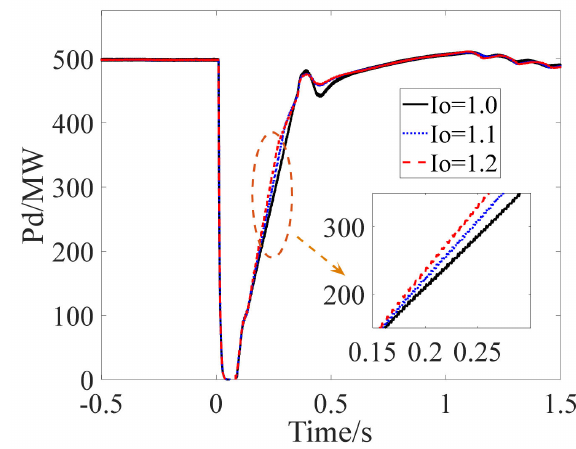
Figure 10. Different I o values of the